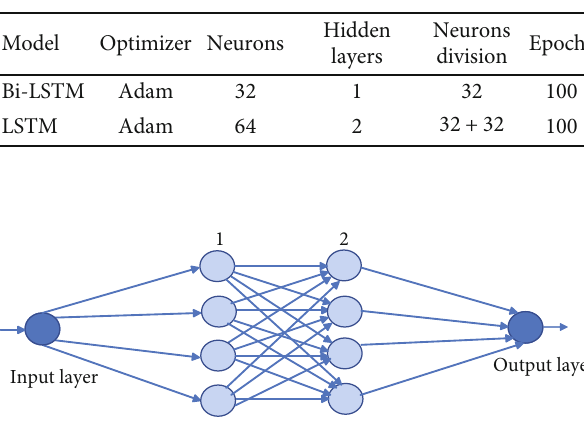
Figure 2: Bidirectional LSTM. Table 1: Con fi guration of layers of RNNs.